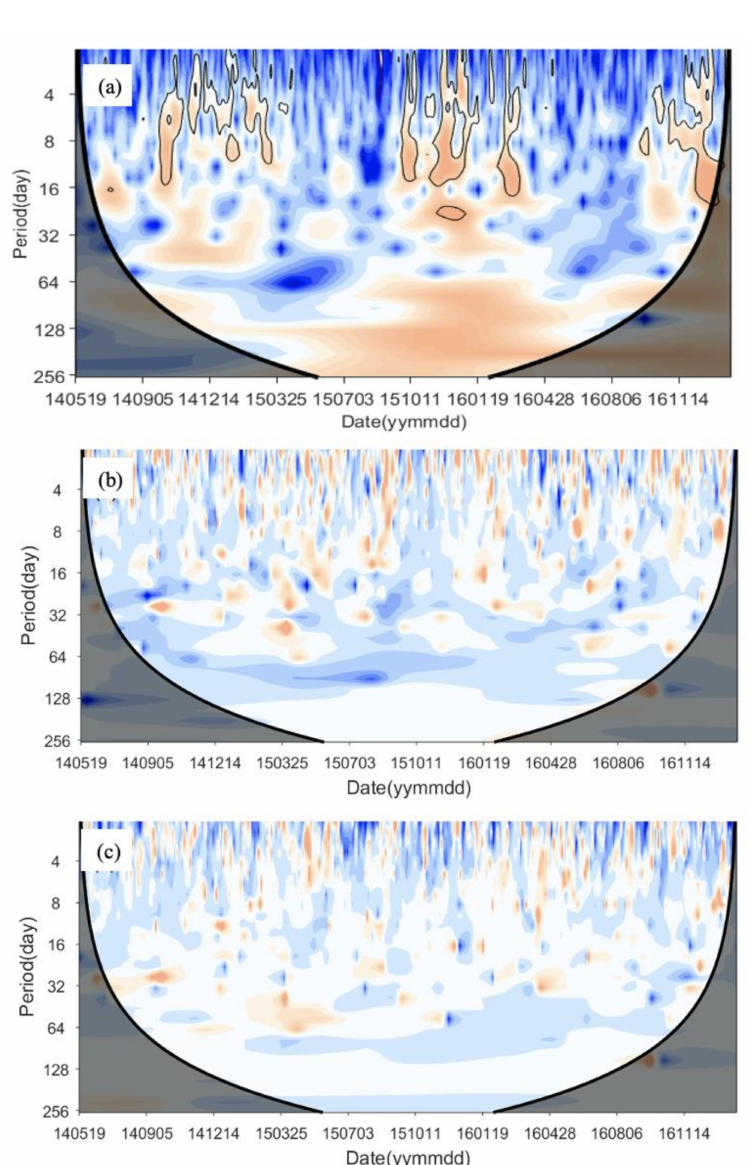
Figure 4. ( a ) The wavelet spectrum of the original PM 2.5 sequence. ( b ) The differences of wavelet spectrum between the original sequence and the ones trained from Exp. 1 by the BP algorithm, and ( c ) Exp. 2 by the EEMD+BP